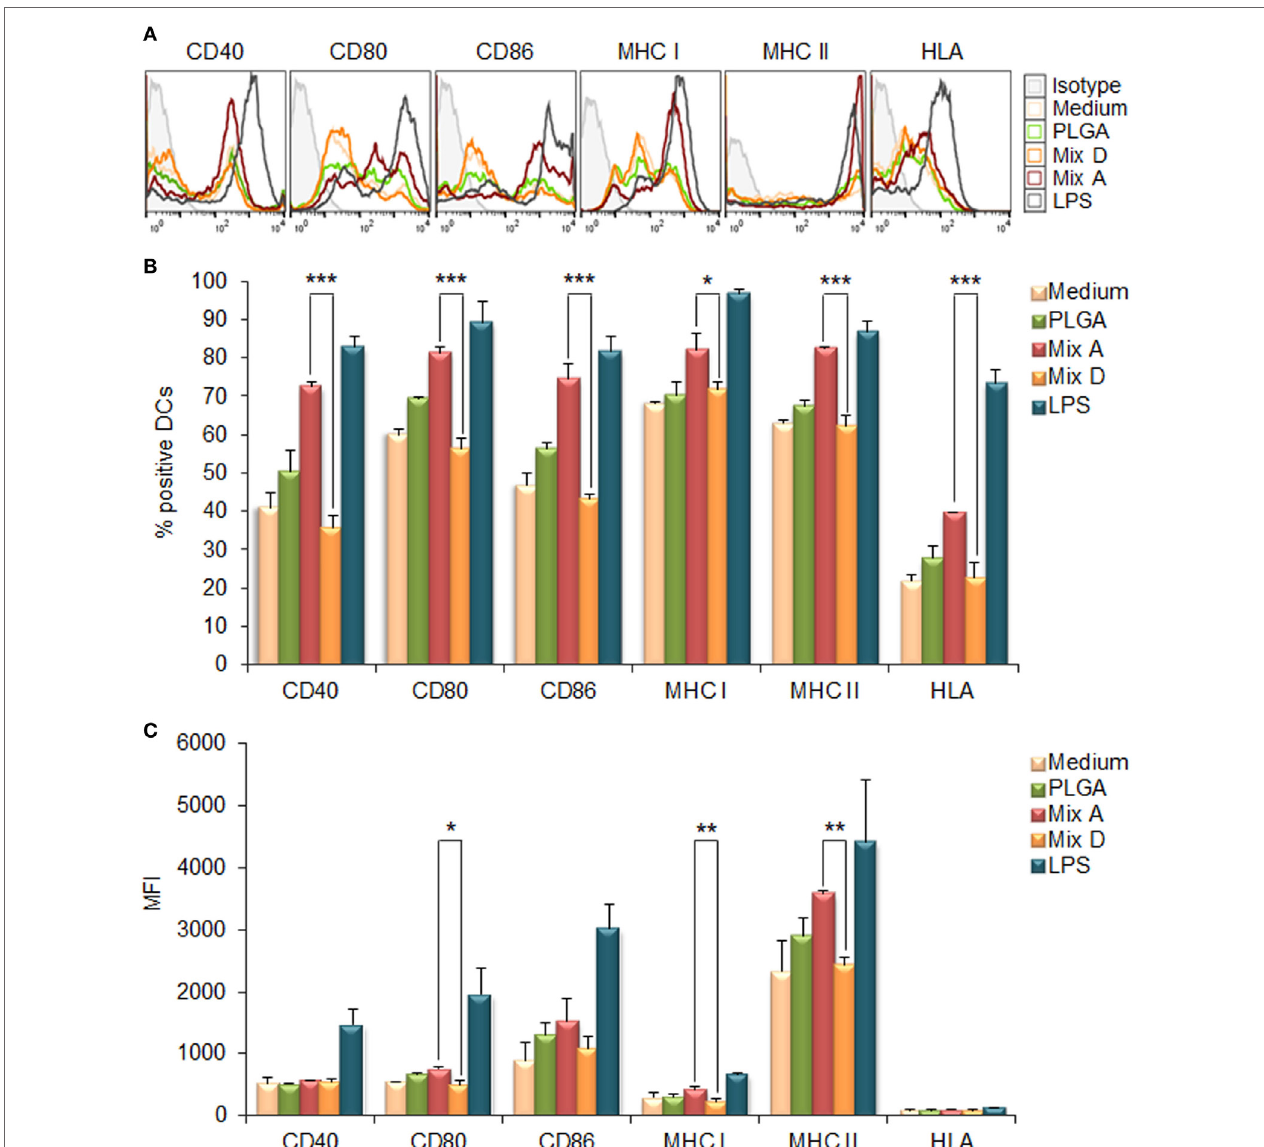
FigUre 2 | Encapsulation of chimeric peptides in poly(lactic- co -glycolic) acid (PLGA) nanoparticles (NPs) induced a strong maturation profile in dendritic cells (DCs) from HLA A2.1 transgenic mice. DCs were cultured for 24 h upon stimulation with the mix of PLGA-chCPAp, PLGA-chH1p, and PLGA-KMP-11p nanoformulations (mix A), the mix of soluble chimeric peptides (mix D), or empty PLGA NPs (control group). DCs cultured in medium alone or in the presence of 1 µg/ml LPS were used as negative and positive control, respectively. (a) Representative histogram plots of CD40, CD80, CD86, major histocompatibility complex (MHC) class I, and class II molecules levels. (B) Diagram demonstrating the percentage (%) of DCs expressing the co-stimulatory and MHC class I and class II molecules. (c) Diagram demonstrating the mean fluorescence index (MFI) of DCs expressing the co-stimulatory and MHC class I and class II molecules. Results are expressed as the mean ± SD of three independent experiments. Significant differences are indicated by * p < 0.05, ** p < 0.01, or *** p <